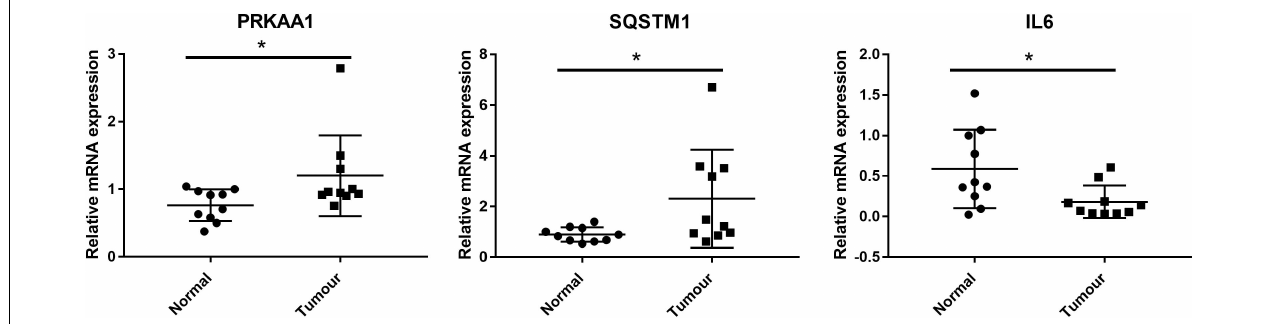
FIGURE 6 | Clinical validation of the expression of CIT downstream genes (including PRKAA1, SQSTM1, and IL6) by qRT-PCR. PRKAA1 and SQSTM1 expression were significantly upregulated in ESCC tissues in comparison with adjacent normal tissues, while the IL6 expression was remarkably downregulated. * P <